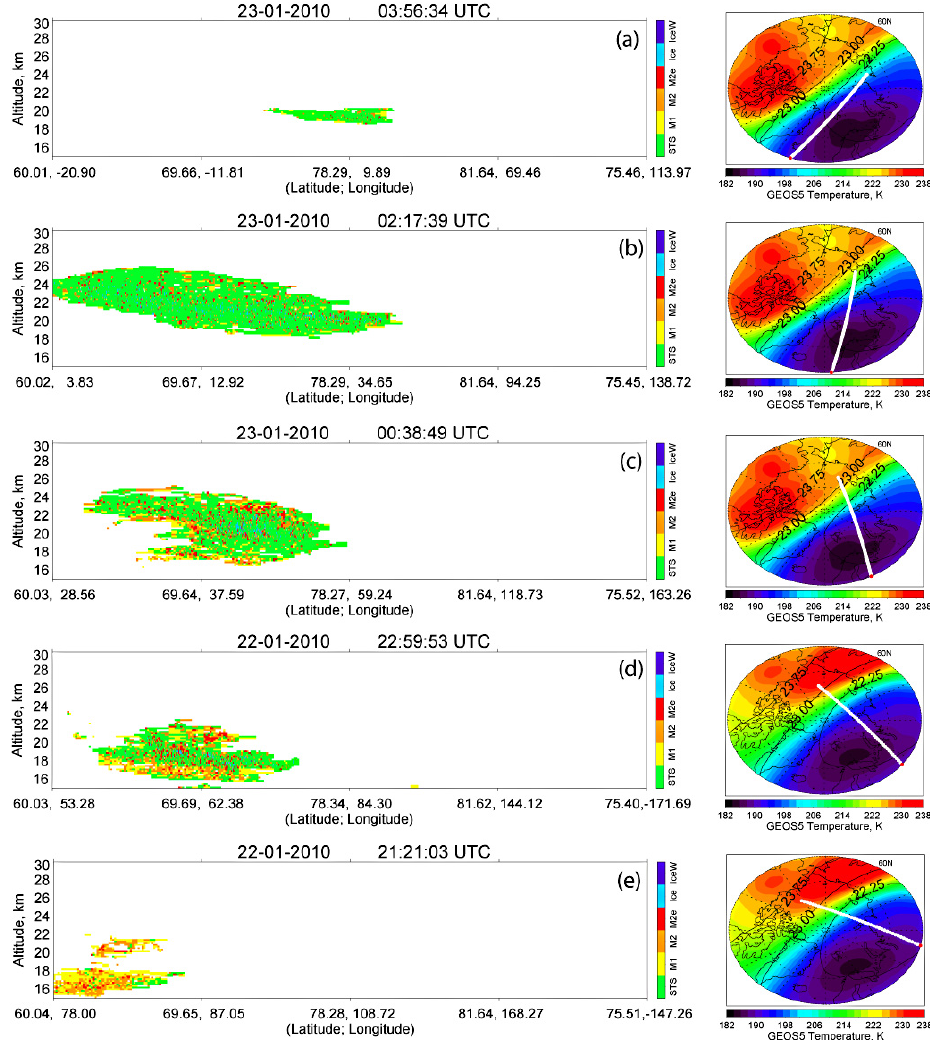
Fig. 16. Examples of CALIPSO PSC observations from five consecutive orbits during 22–23 January 2010. GEOS5 temperature and geopotential height fields at 30hPa for 12:00UTC 23 January are shown on the right with the location of the corresponding CALIPSO orbit tracks indicated by the white